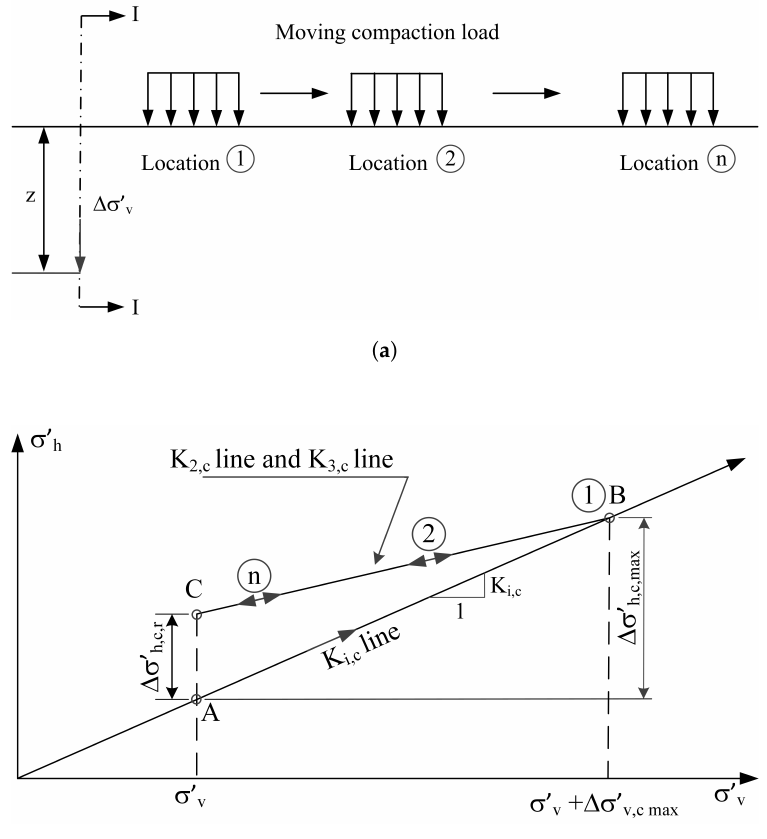
Figure 1. ( a ) Schematic diagram of a moving compaction load. ( b ) Stress paths of a soil element at depth z as the compaction load moves away from